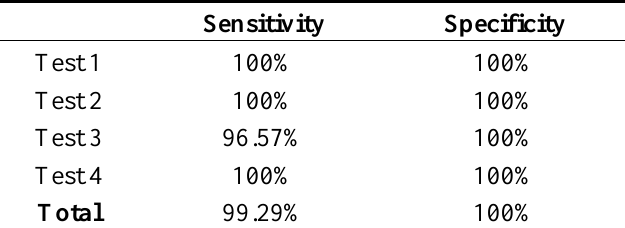
Table 9. Statistic results for extrasystoles detection.